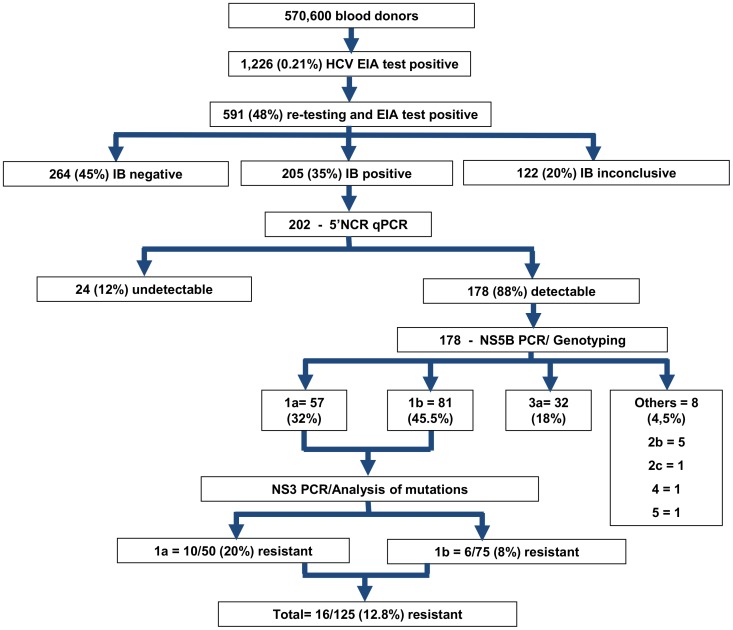
Flowchart summarizing the routine screening and confirmatory testing for HCV and the results of the genotyping and protease inhibitor-resistance mutation analyses.Notes: EIA - Enzyme immunoassay (EIA); IB - Immunoblot assay.